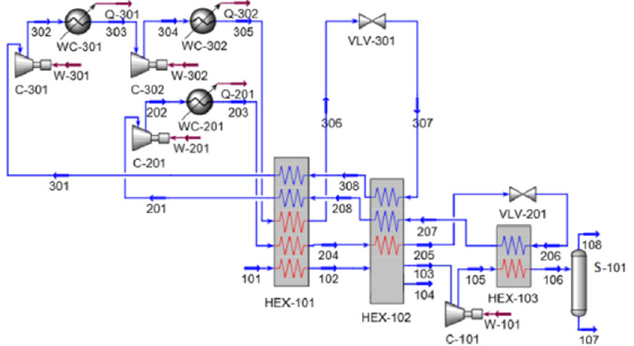
Figure 53. CH 4 -C 2 H 6 PLNG process with CO 2 cryogenic removal [207]. Reproduced with permission from Elsevier (license number 5413471341623).